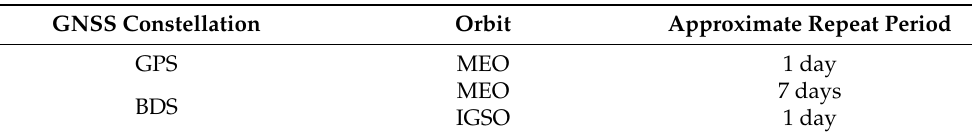
Table 1. Approximate satellite repeat periods of GPS and BDS satellites. (Here, the repeat period of a BDS IGSO satellite is 1 day due to its geosynchronous